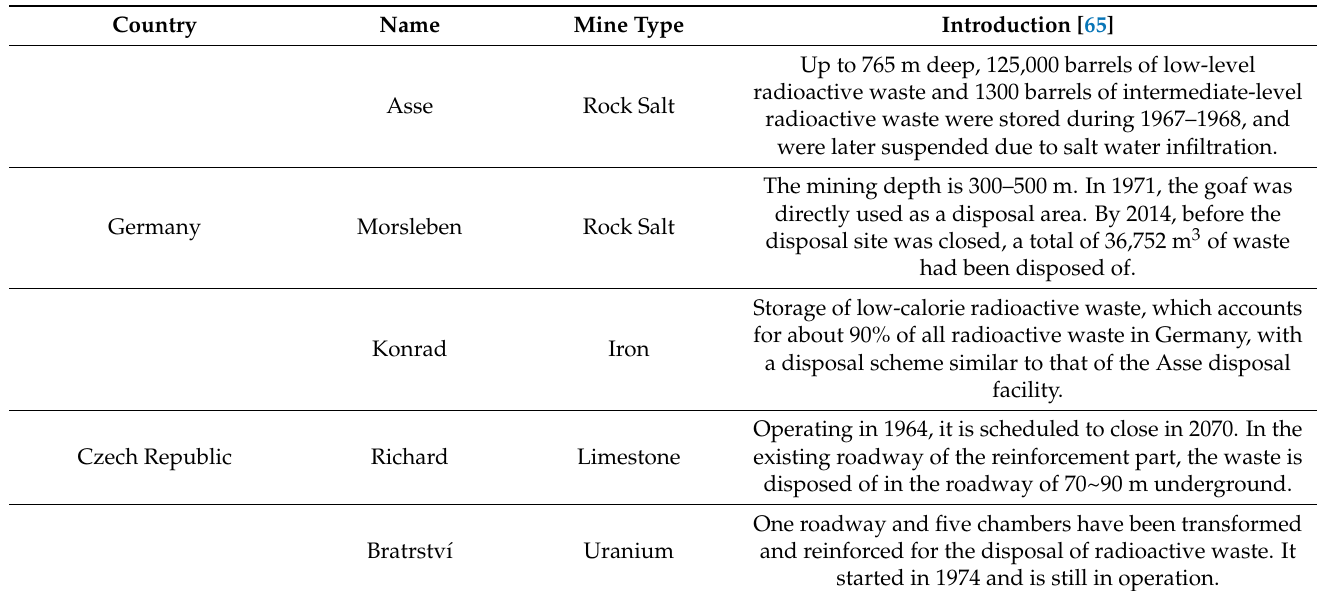
Table 2. Abandoned mine shafts as disposal facilities of low-and-intermediate-level radioac- tive